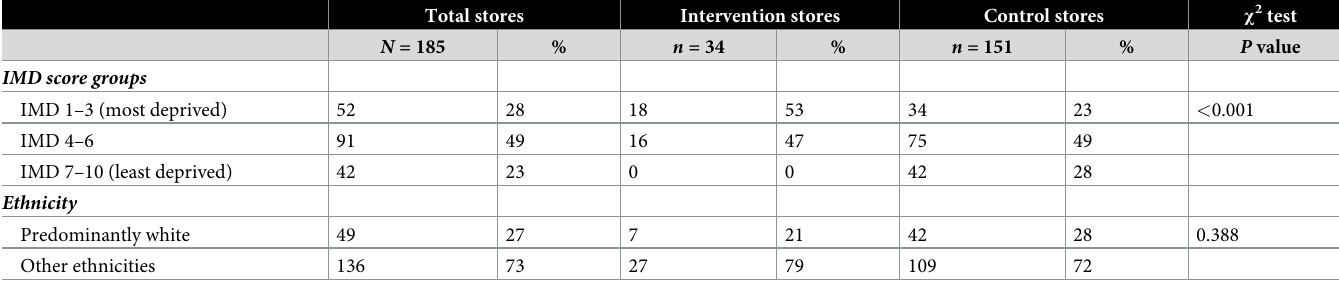
Table 1. Store demographic characteristics.